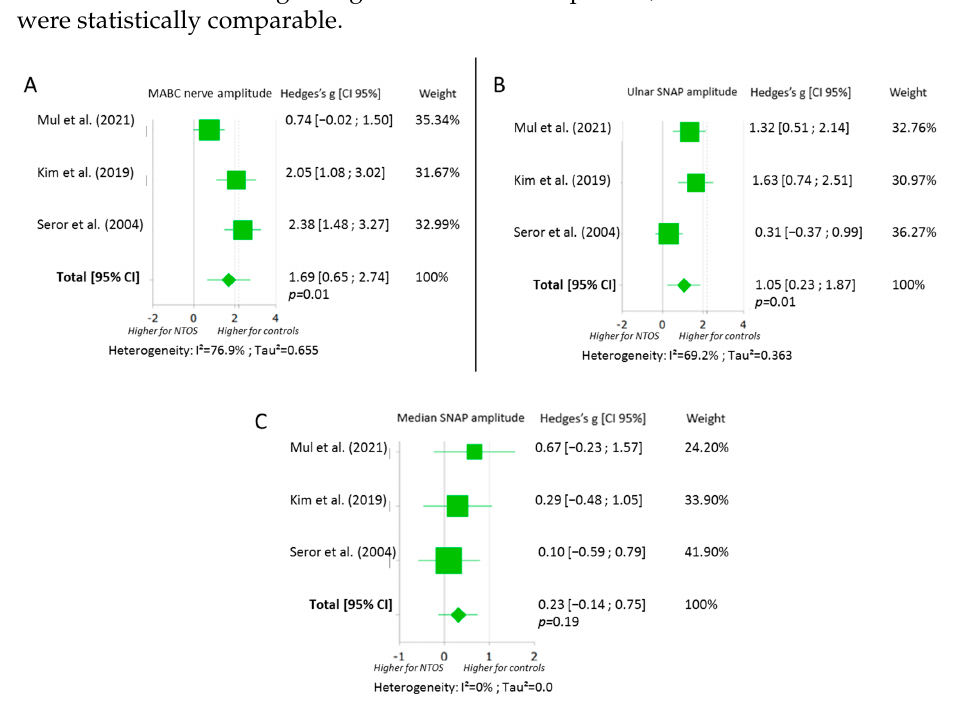
Figure 2. Forest plots of the sensory nerve conduction studies for MABC ( A ), ulnar ( B ) and median nerves ( C ) [28,29,32]. Abbreviations: MABC: medial antebrachial cutaneous; SNAP: sensory nerve action potential; NTOS: neurogenic thoracic outlet syndrome; CI: confidence interval.